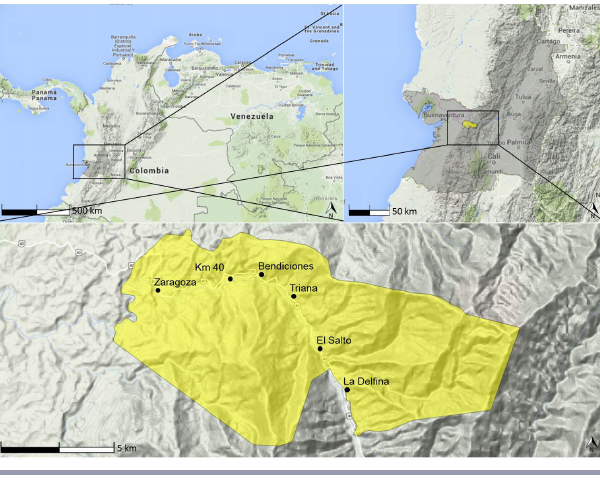
Fig. 1 . Location of the Colombian social-ecological system.